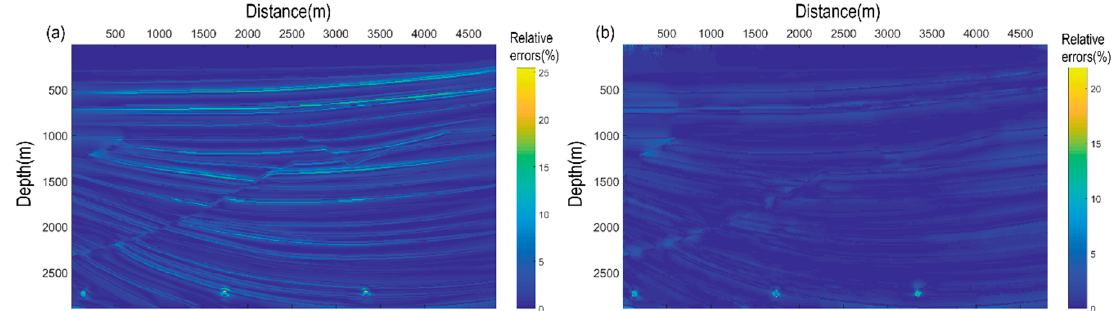
Figure 6. The relative error profile of inverted AI from conventional GBM ( a ), and the proposed method broadband GBM ( b ), where these relative errors are calculated by | Inverted AI